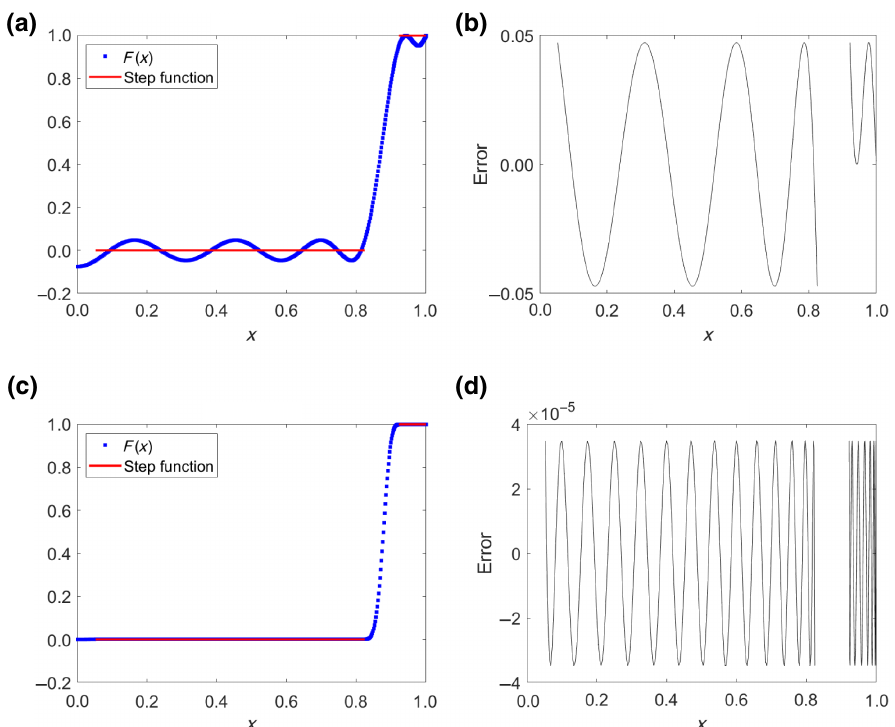
FIG. 2. The polynomial obtained by convex optimization approxi- mating the shifted sign function and the pointwise error on [ σ min , σ − ] ∪ [ σ + , σ max ] with d = 20 (a),(b) and d = 80 (c),(d).